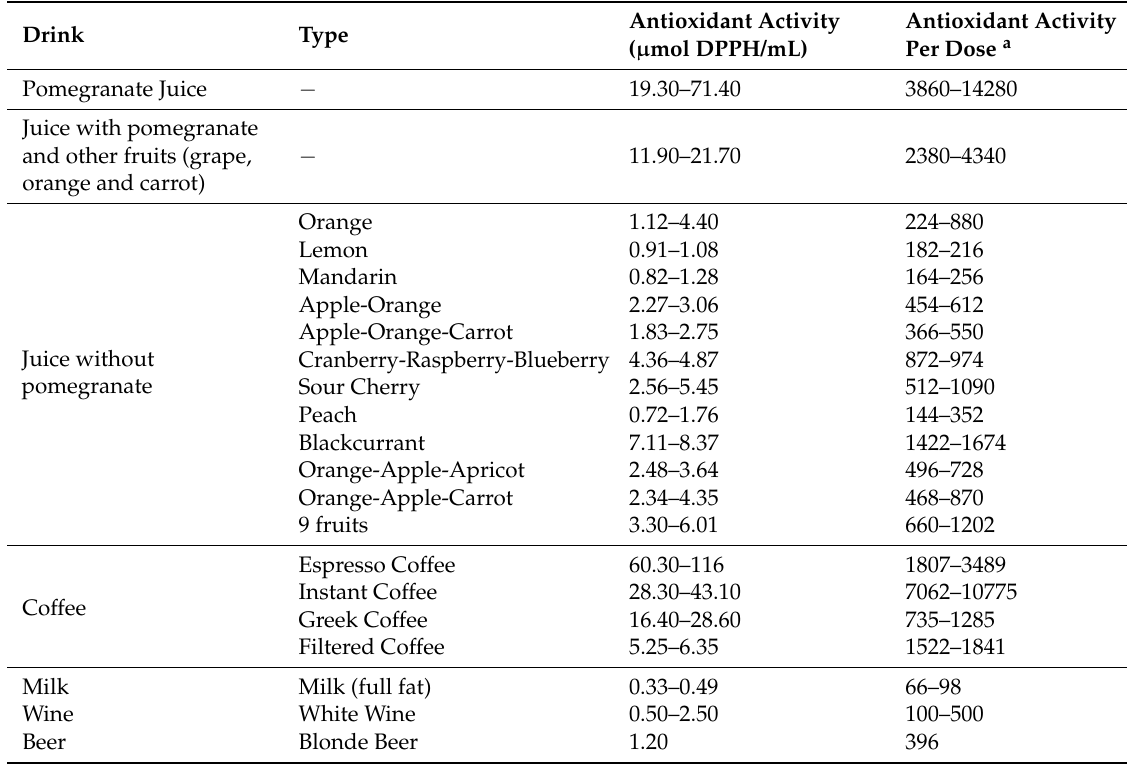
Table 2. The summary of the tested